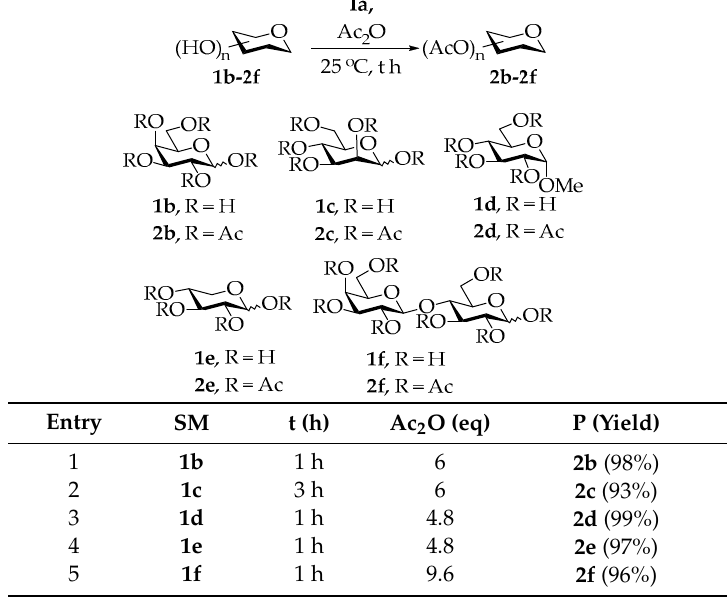
Table 2. Ionic liquid ( Ia ) catalyzed the solvent-free per- O -acetylation of hexoses.